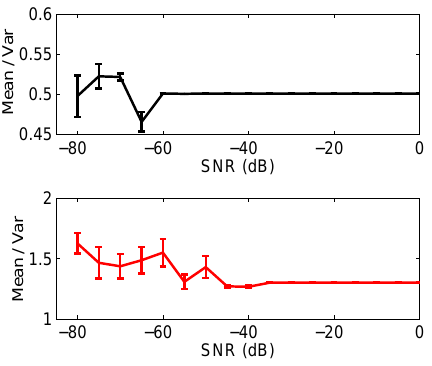
Figure 5. Estimated means and variances of the heart and respiration for 20 realizations of TOCC in each SNR levels (SIR = 0